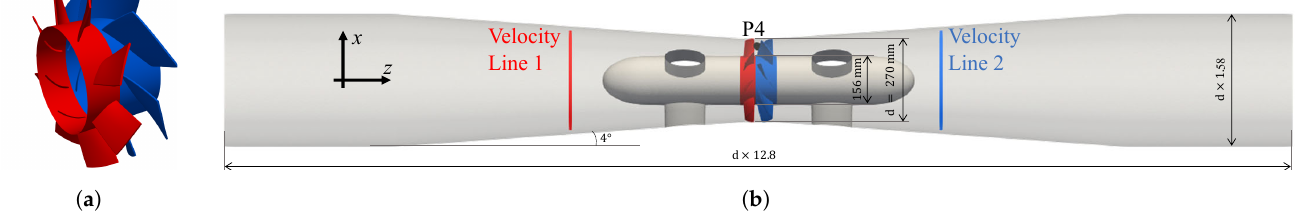
Figure 1. Blade geometry and computational domain. ( a ) Runner 1 (red) and Runner 2 (blue). ( b ) Computational domain with the coordinate system, geometrical dimensions, location of pressure probe P4, and velocity lines 1 and 2. In pump mode, the flow is from left to right (positive z ) and, in turbine mode, from right to left (negative z